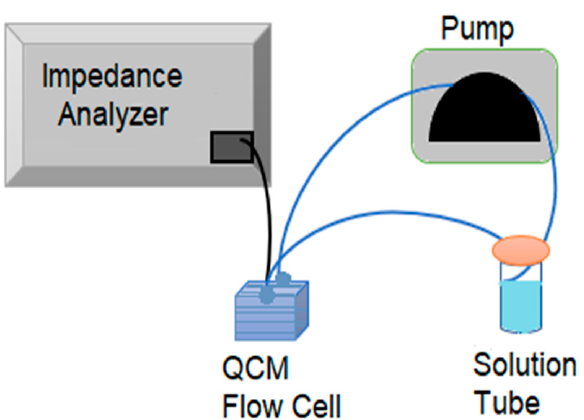
Figure 2. Schematic diagram of the QCM experiment flow setup.